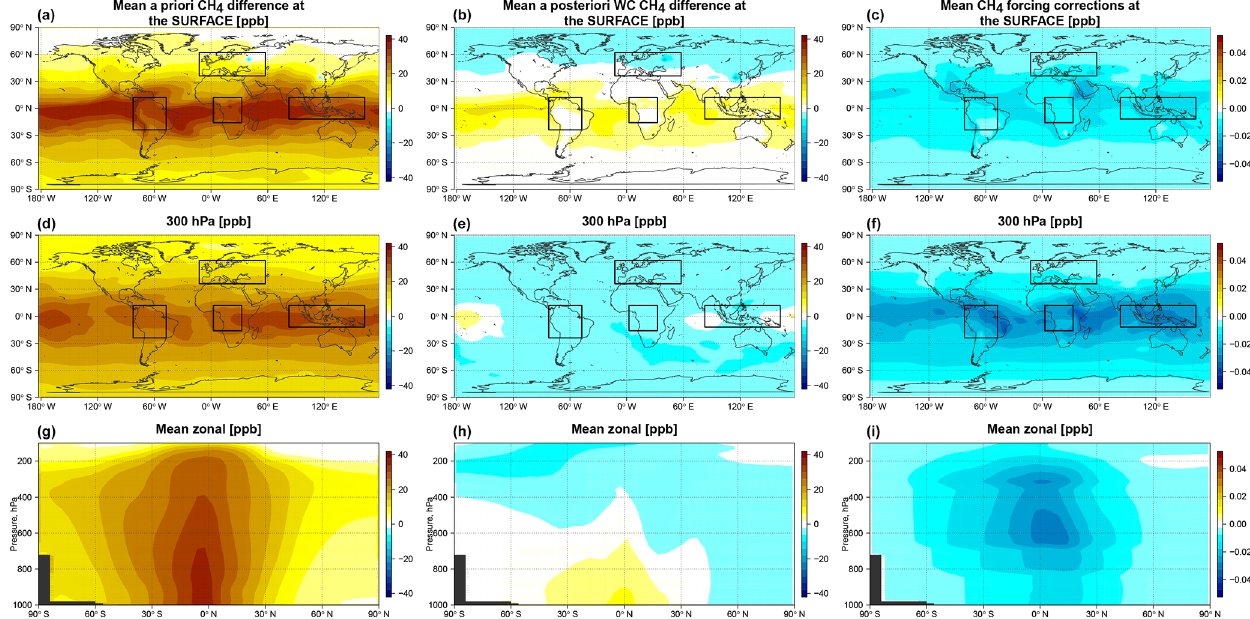
Figure 3. Mean differences in the CH 4 distribution in March 2010 in the OSSE with biased chemistry. (a, d, g) Mean differences between the a priori CH 4 state and the true CH 4 state. (b, e, h) Mean differences between the WC optimized CH 4 state and the true CH 4 state. (c, f, i) The mean WC state corrections (the forcing terms) in parts per billion (ppb). Shown are the latitude–longitude differences at (a–c) the surface and (d–f) at 300hPa, as well as the altitude–longitude differences (g–i) along the Equator. The black boxes indicate the four domains considered for the regional analysis discussed in the text and shown in Fig. 4. Table 1. Evaluation of a priori, SC_4x5, and WC_4x5 optimized CH 4 fields using TCCON XCH 4 from the stations listed in Table 2 and NOAA surface in situ observation (mean statistics for the period of February–May 2010). The first, second, and third columns represent the mean difference, standard deviation, and correlation between the model and measurements, respectively. The fourth column represents the slope of the regression line, with modeled data on the y axis and measurements on the x axis. Mean difference Standard deviation Correlation ( R ) Slope of regression (ppb) (ppb) Prior SC WC